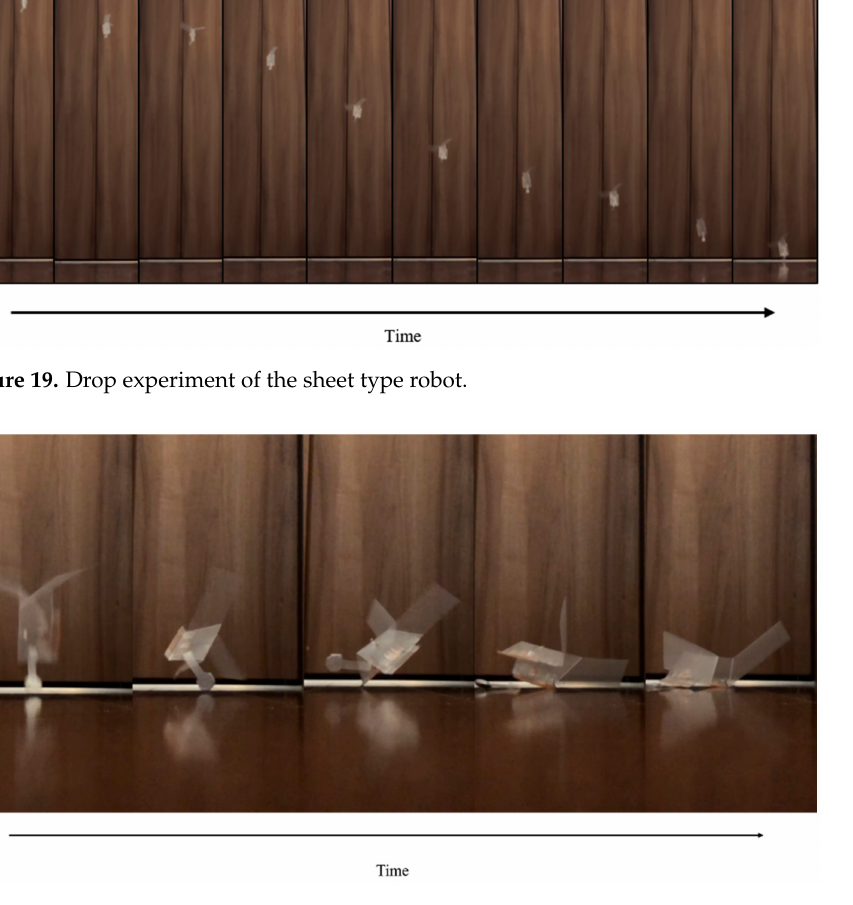
Figure 20. Deformation due to the weight detachment.